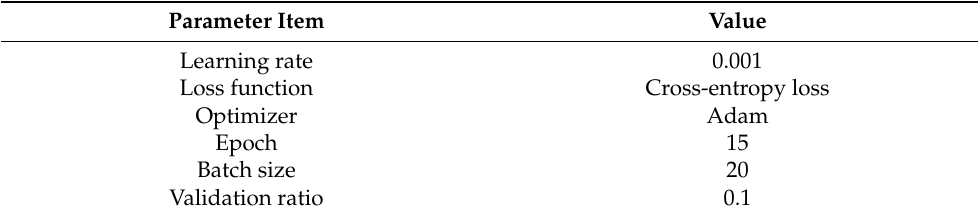
Table 7. The relevant parameter settings for DCNN network.